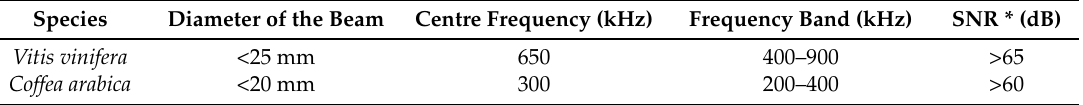
Table 2. Design parameters for NC-RUS sensors for Vitis vinifera and Coffea arabica .